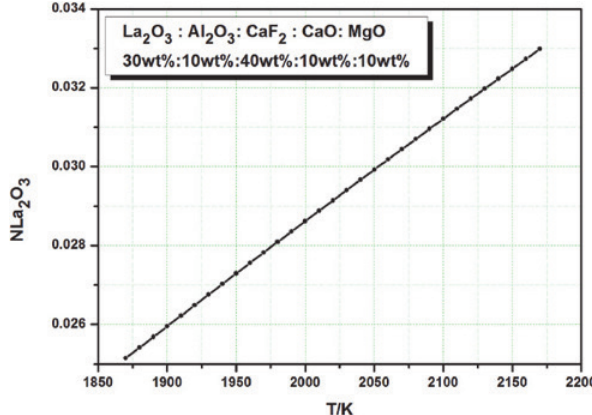
Fig. 7: The influence of temperature on mass action concentration of La 2 O